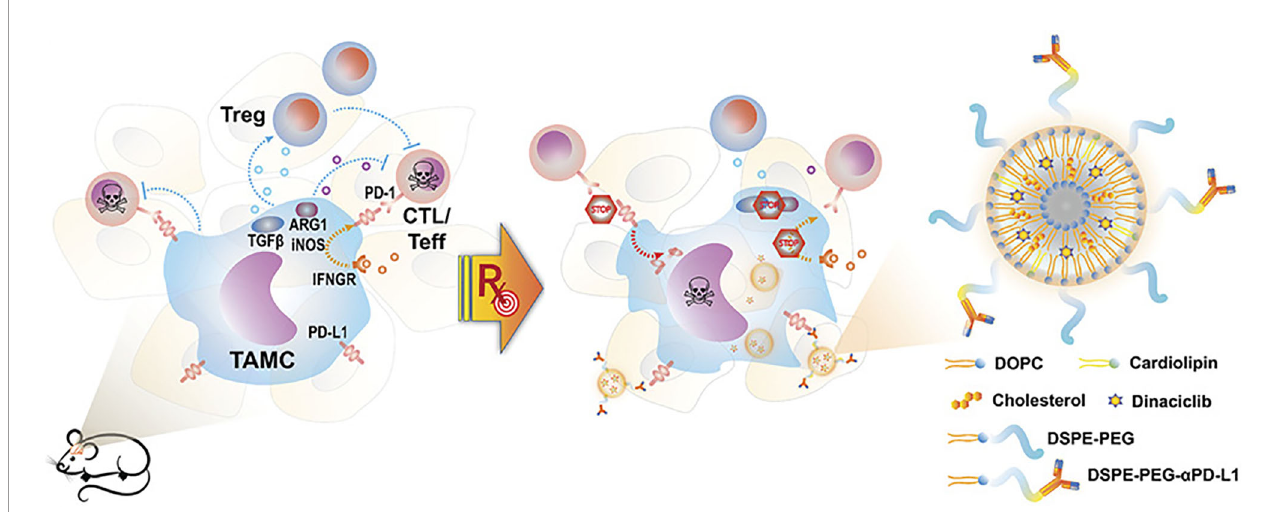
FIGURE 4 | Schematic representation of nano-targeting of glioma-associated TAMCs. (CTL, cytotoxic T lymphocyte; Teff, effector T cell; PD-1, programmed cell death protein 1; IFNGR, IFN gamma receptor)